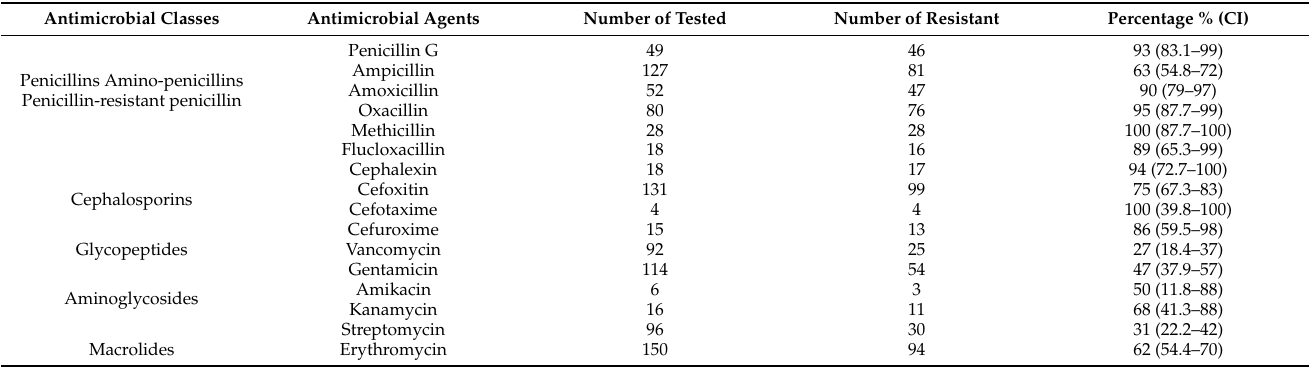
Table 9. Characteristics of antimicrobial resistance of methicillin-resistant S. aureus (MRSA) from meat and meat products in African